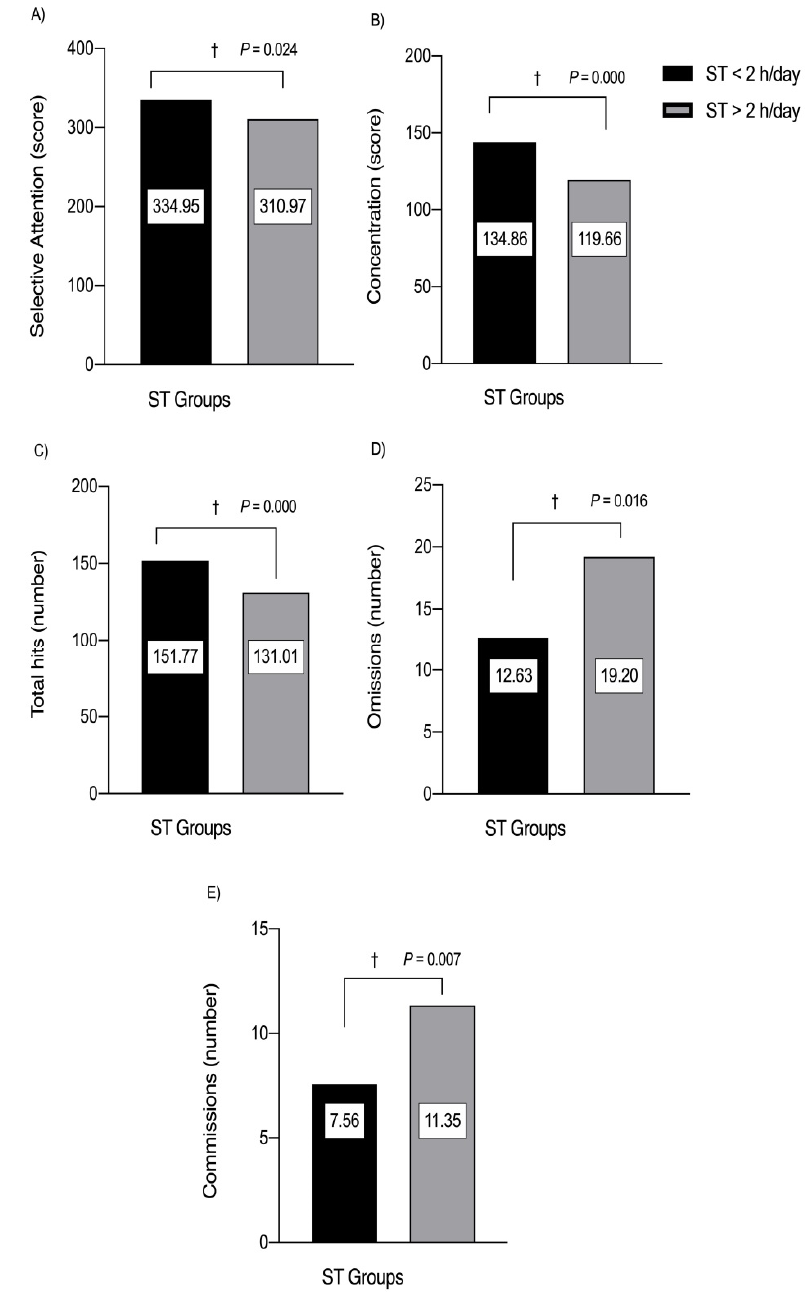
Figure 2. Selective attention ( A ), concentration ( B ), total hits ( C ), omissions ( D ) and commissions ( E ) characteristics in schoolchildren participants by ST groups (<2 h/day/ ≥ 2 h/day). (†) Daggers denotes significant differences by group at each respective p -value.